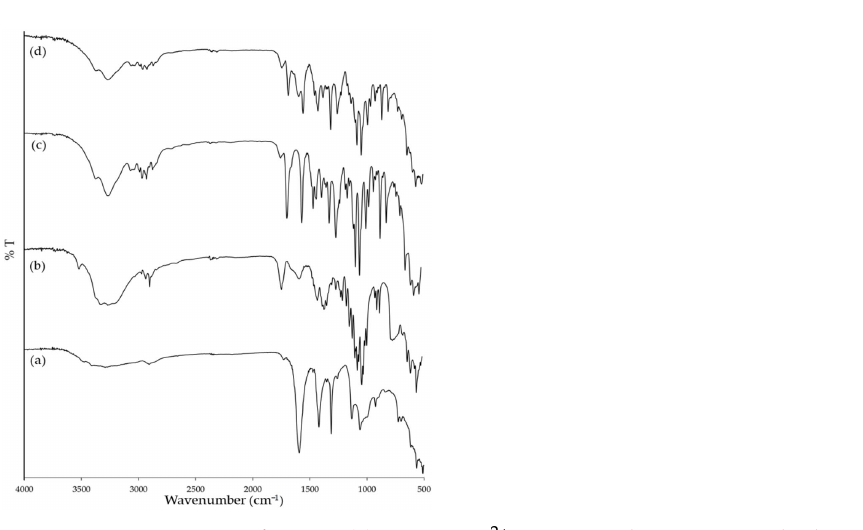
Figure 4. FTIR spectra of CMCS ( a ); CMCS-Ca 2+ nanoparticle containing clindamycin HCl ( b ); clindamycin HCl ( c ); and physical mixture of CMCS and clindamycin HCl ( d ). 3.5. Clindamycin HCl Content in CMCS-Ca 2+ Nanoparticles Clindamycin HCl loading content is shown in Table 4. The result showed that the drug content was increased when the particle size increased. For example, when the par-